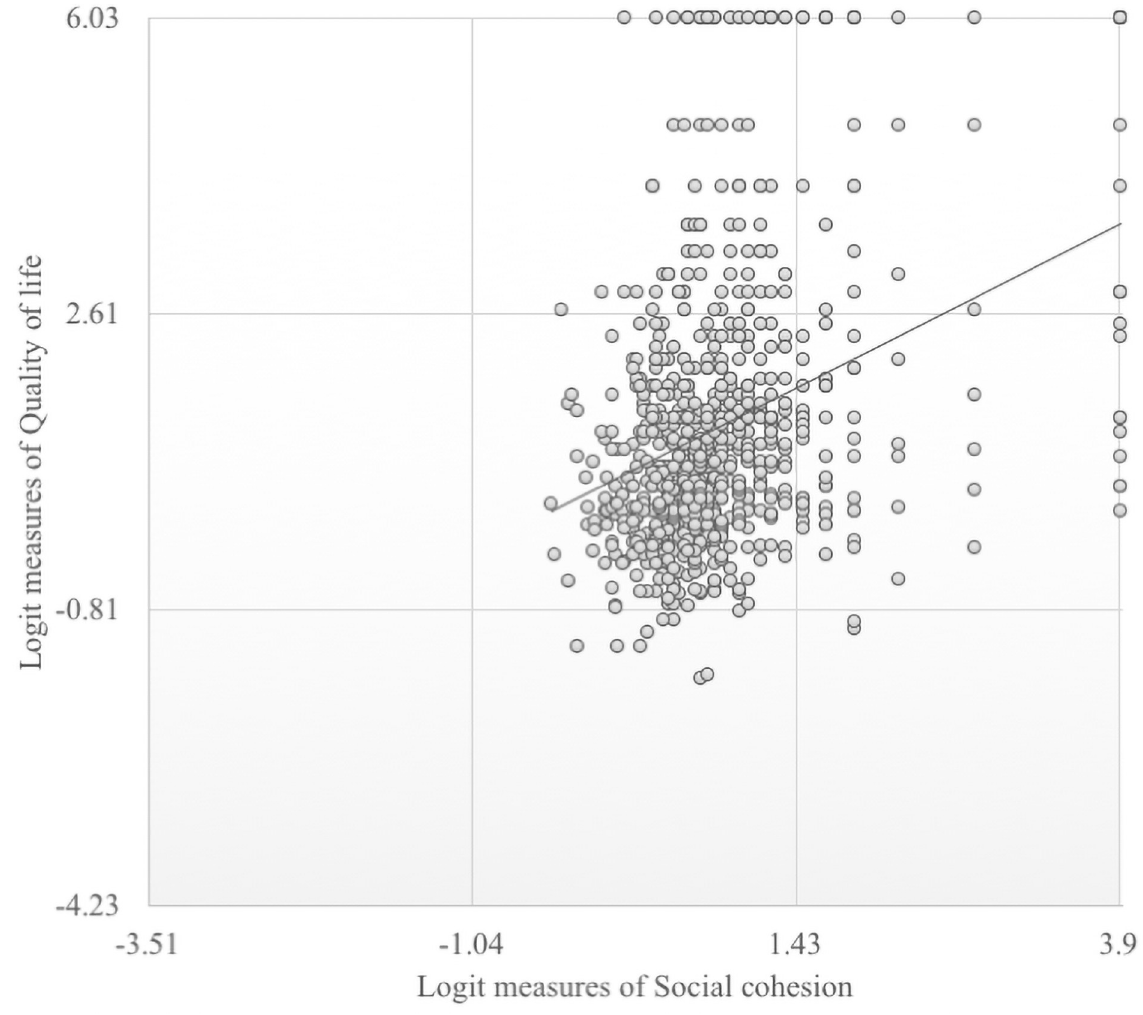
Fig 1. Respondents’ measures of social cohesion and quality of life. This figure describes the distribution of social cohesion and QOL of the respondents in logit measures; On the basis of our instruments, the possible logit ranges of social cohesion measures are from –3.51 to 3.91 while the possible ranges of QOL measures ranges from –4.23 to 6.03. For the social cohesion measures, − 3.51 to − 1.04 was interpreted as low, − 1.04 to 1.43 was interpreted as medium, and 1.43 to 3.9 was interpreted as high. For the QOL measures, − 4.23 to − 0.81 was interpreted as low, − 0.81 to 2.61 was interpreted as medium, and 2.61 to 6.03 was interpreted as